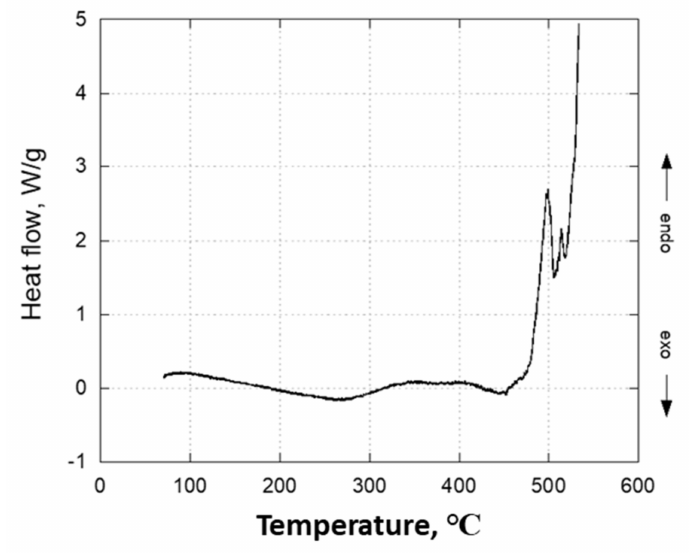
Figure 4. DSC curve of the [Zn(4,4 (cid:48) − bipy)Cl 2 ] ∞